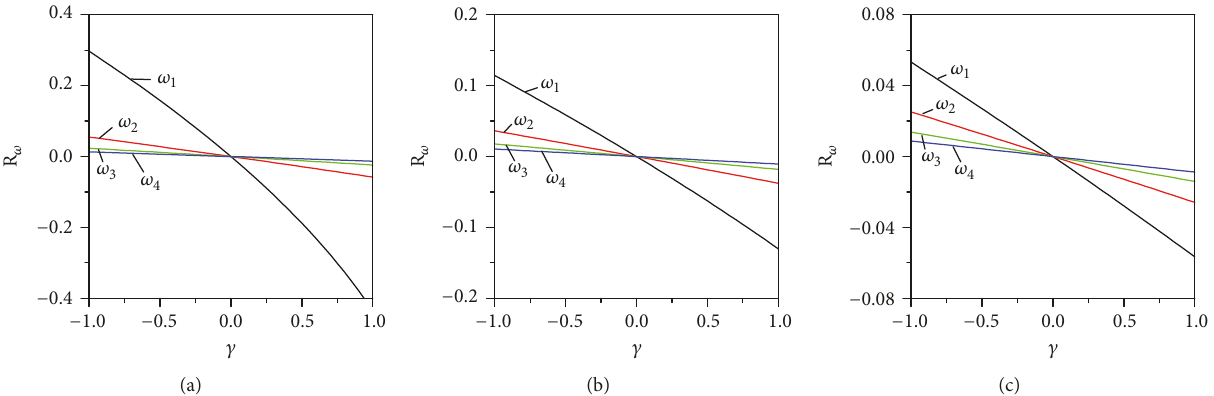
Figure 1: Temperature effects on the first four natural frequencies: (a) hinged-hinged; (b) hinged-fixed; (c) fixed-fixed.